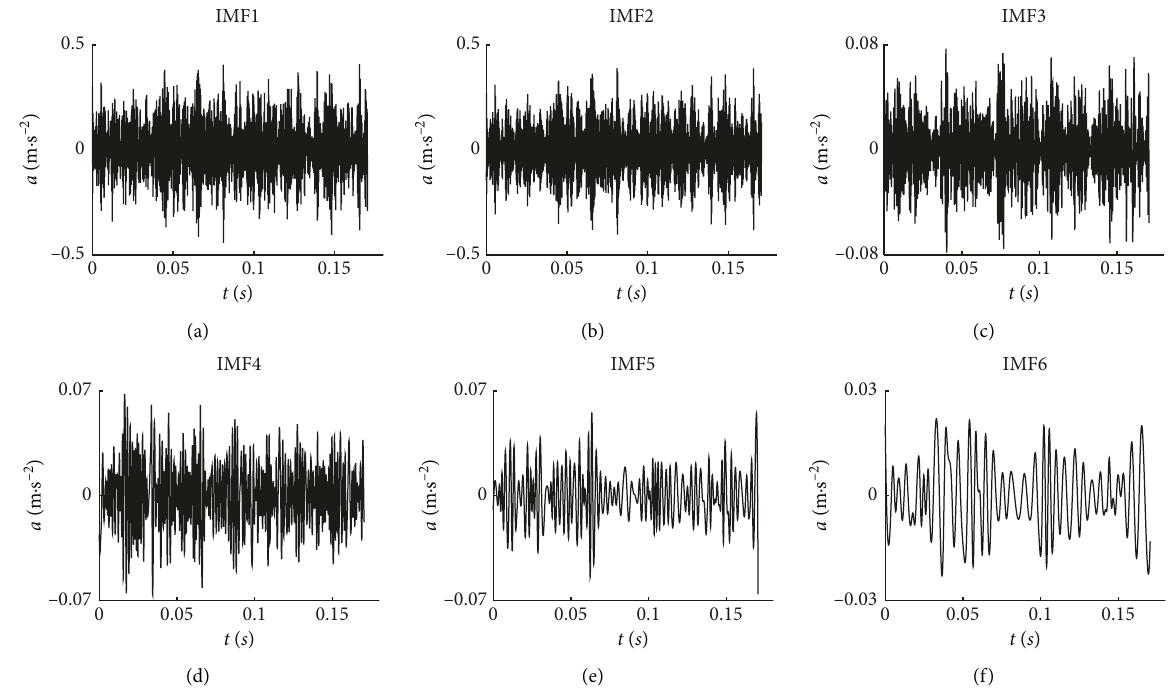
Figure 8: The first six IMF components of EEMD for the BF07 signal: (a) IMF1; (b) IMF2; (c) IMF3; (d) IMF4; (e) IMF5; (f) IMF6. Table 3: The FDE of the trend and detrend of the rolling bearing under various states. Signal type